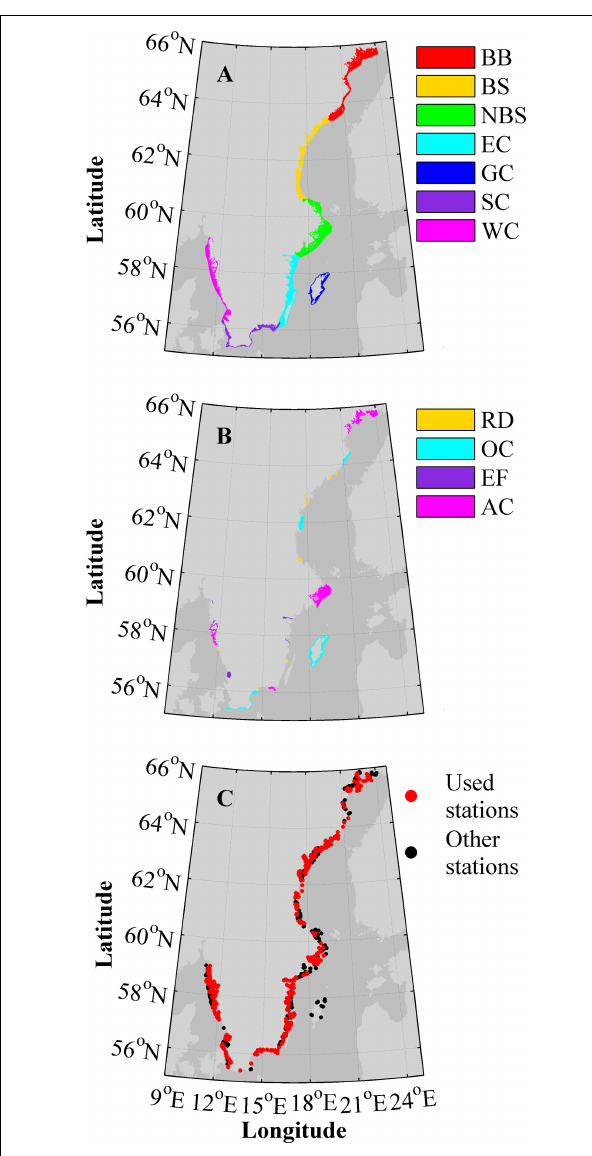
FIGURE 1 | Maps of the Swedish coastline with abbreviations in the legends according to Table 1 . (A) The seven major regions, i.e., the five water districts (WD1, WD2, WD3, WD4, and WD5) where WD4 is divided in three parts. (B) The key sites colored after type. (C) The coastal monitoring stations